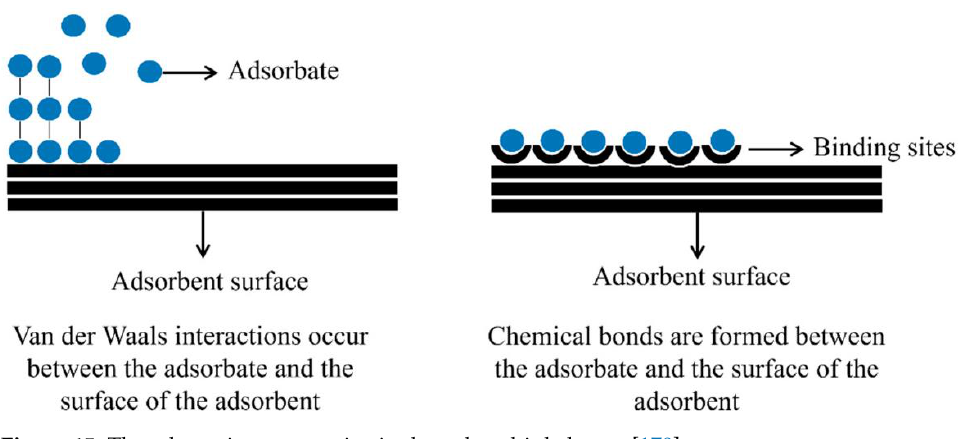
Figure 15. The adsorption process in single and multiple layers [170].